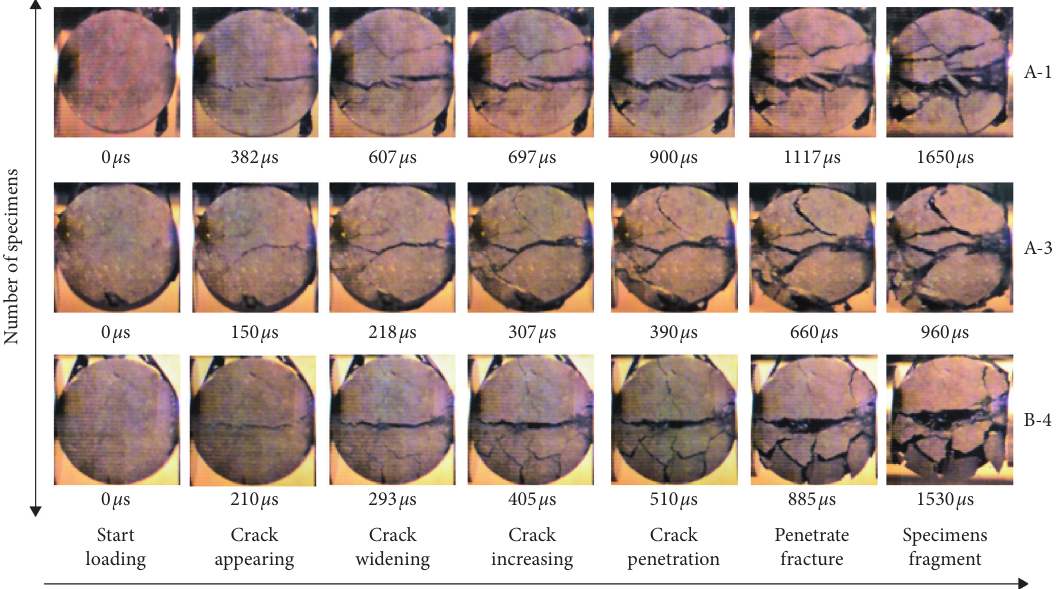
Figure 7: Typical dynamic tensile crack initiation and propagation